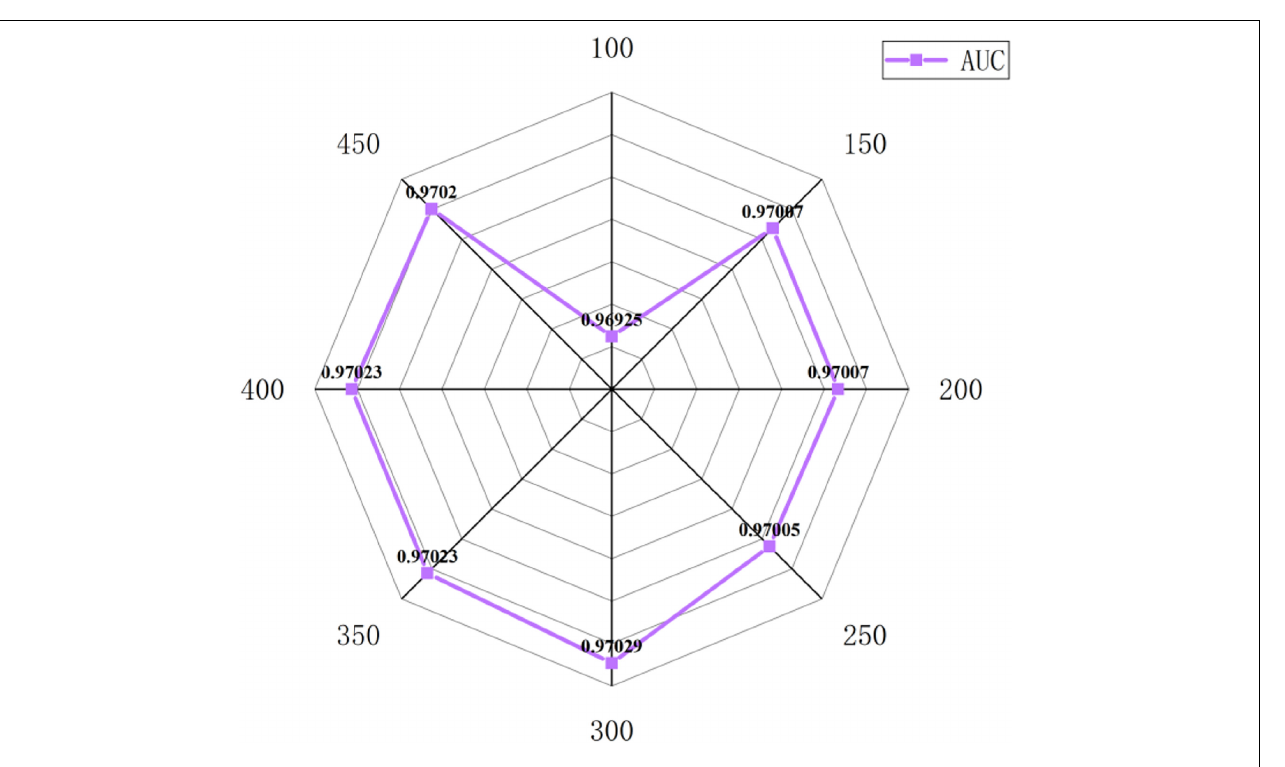
FIGURE 7 | The AUC value of different n_estimators